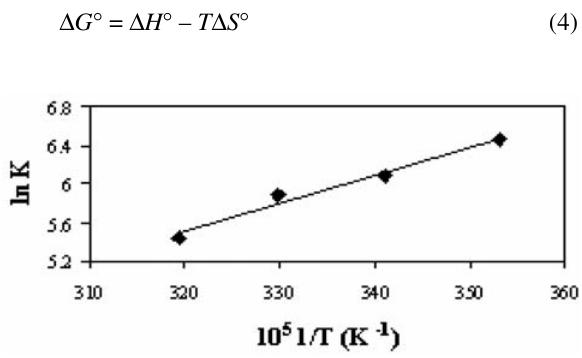
Figure 3. The plots of ln K vs. 1/ T for [ Co(cdacacen)(PBu Im in